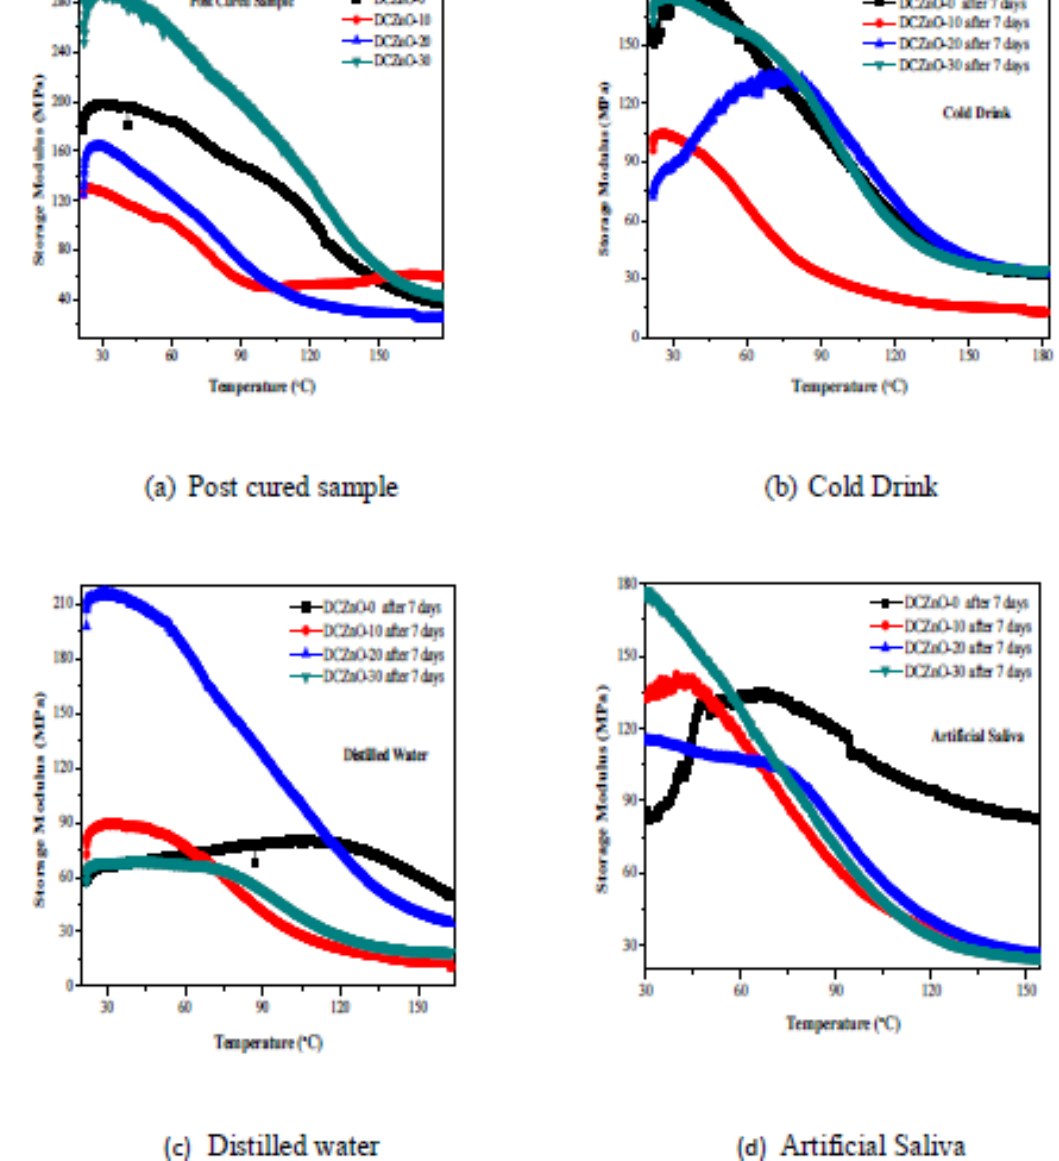
Figure 3: Variation of storage modulus of (a) Post cured sample (b) sample kept in Cold Drink for 7 days (c) sample kept in distilled water for 7 days (d) sample kept in artificial saliva for 7